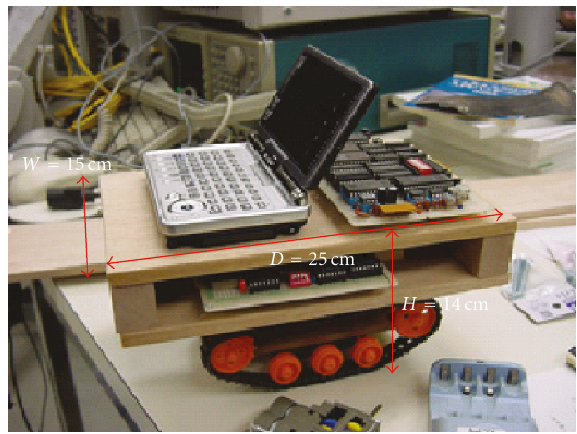
Figure 14: Photograph of a robot.